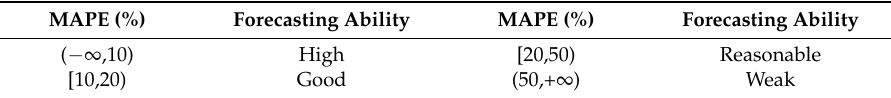
Table 5. MAPE evaluation